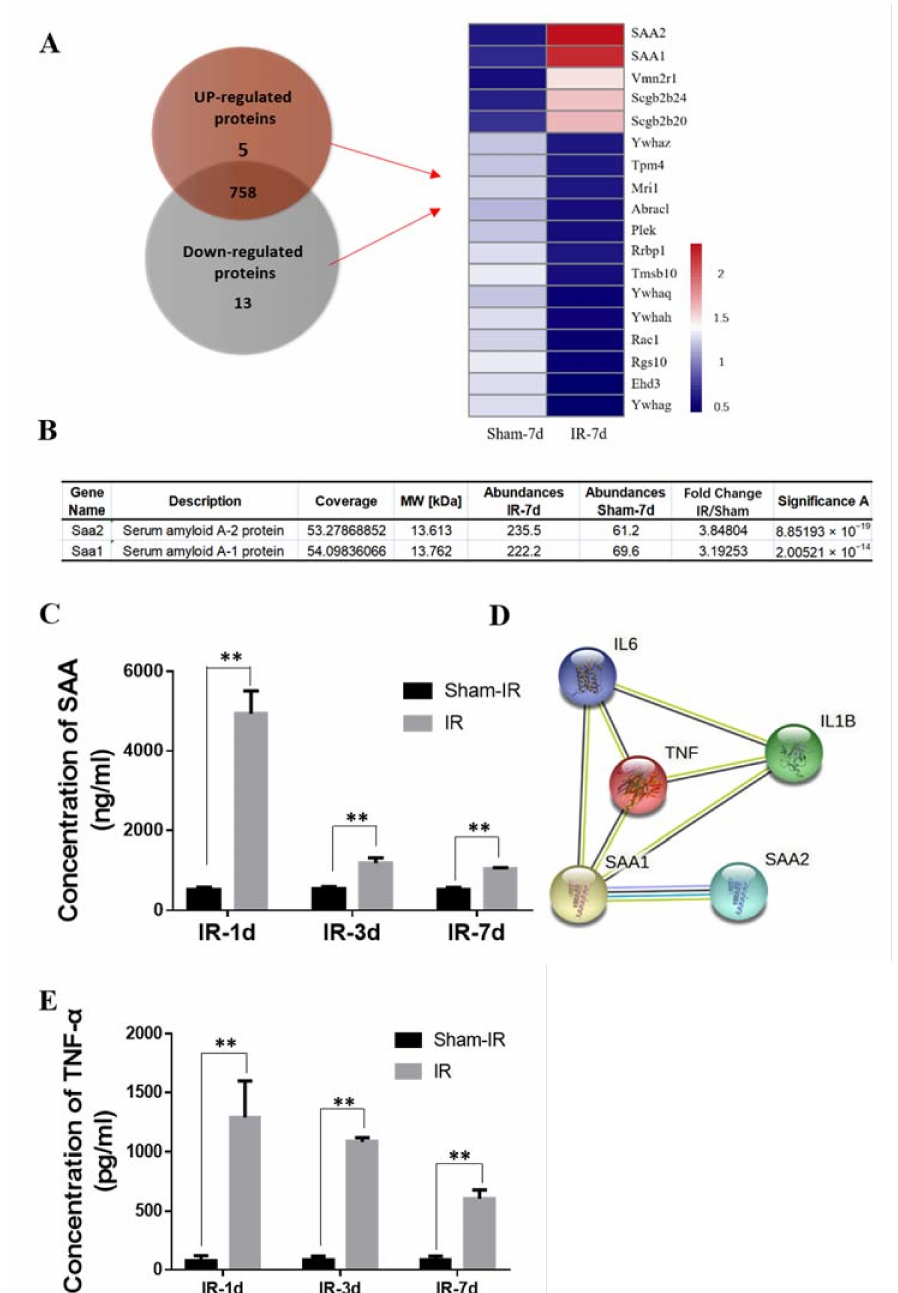
Figure 3. Changes of protein expressions in mouse serum after Th-IR. ( A ) Veen diagram and heat- map analysis of up-regulated proteins (>2 fold) and down-regulated proteins (<1/2 fold) between Th-IR and sham-IR group. ( B ) The expressions of SAA2 and SAA1 were up-regulated in the Th-IR group. ( C ) The concentration of SAA1 in mice serum at different time points after Th-IR. ( D ) STRING online analysis of protein-protein interaction (PPI) among SAA1, SAA2 and inflammatory factors. ( E ) The concentration of TNF- α in mice serum at different time points after Th-IR. ** p < 0.01, compared with sham-IR group. n =